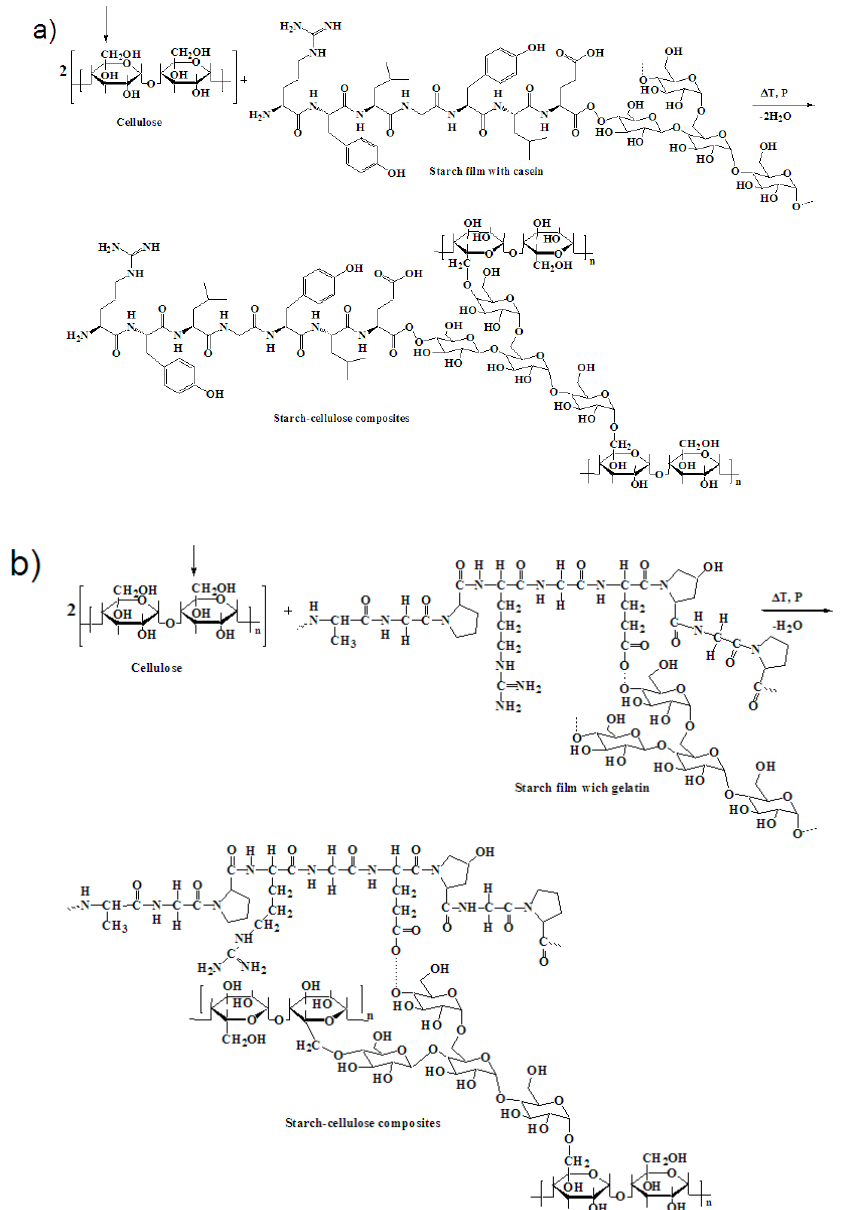
Figure 6. Proposed mechanism of interactions between cellulose and the starch-casein film ( a ) or starch-gelatin film ( b ) leading to the production of cellulose-starch composites.